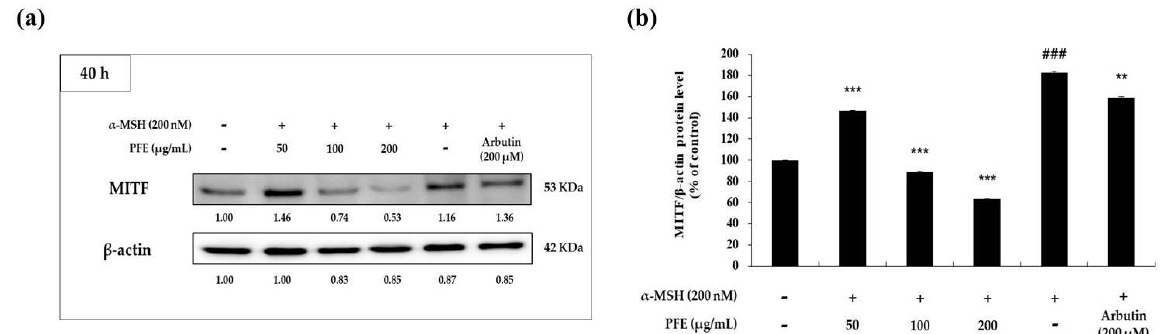
Figure 4. Variation in microphthalmia-associated transcription factor (MITF) expression of B16F10 cells to PFE treatment concentration. The cells, α-MSH-stimulated, were treated with the PFE and arbutin (200 μM) for 40 h. ( a ) The band of MITF and ( b ) the graph by quantified protein levels of MITF. Results in the graph are represented as the mean ± SD of at least triplicate experiments. ### p < 0.001 vs. non-treated. ** p < 0.01, *** p < 0.001 vs. α-MSH-treated alone.